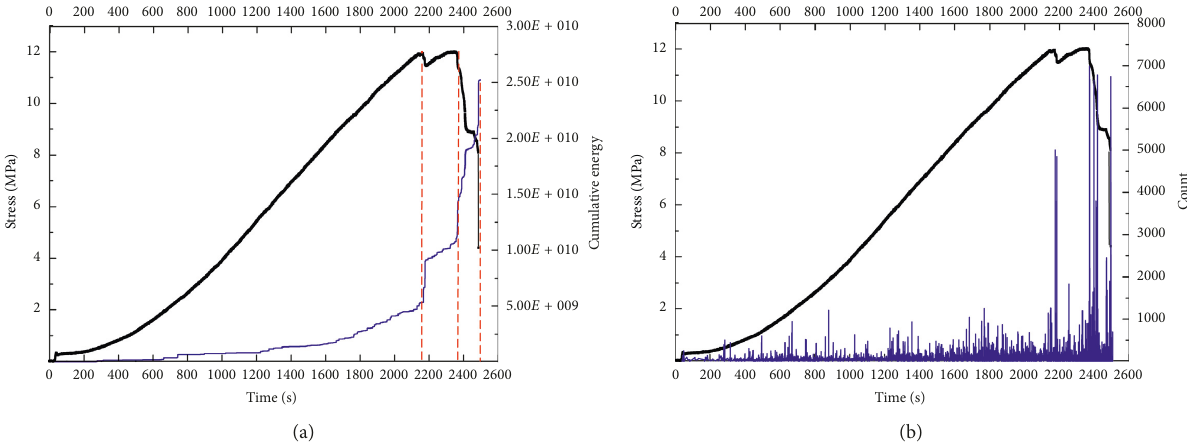
Figure 9: Acoustic emission characteristics of 2 # sample: (a) cumulative energy; (b) count.